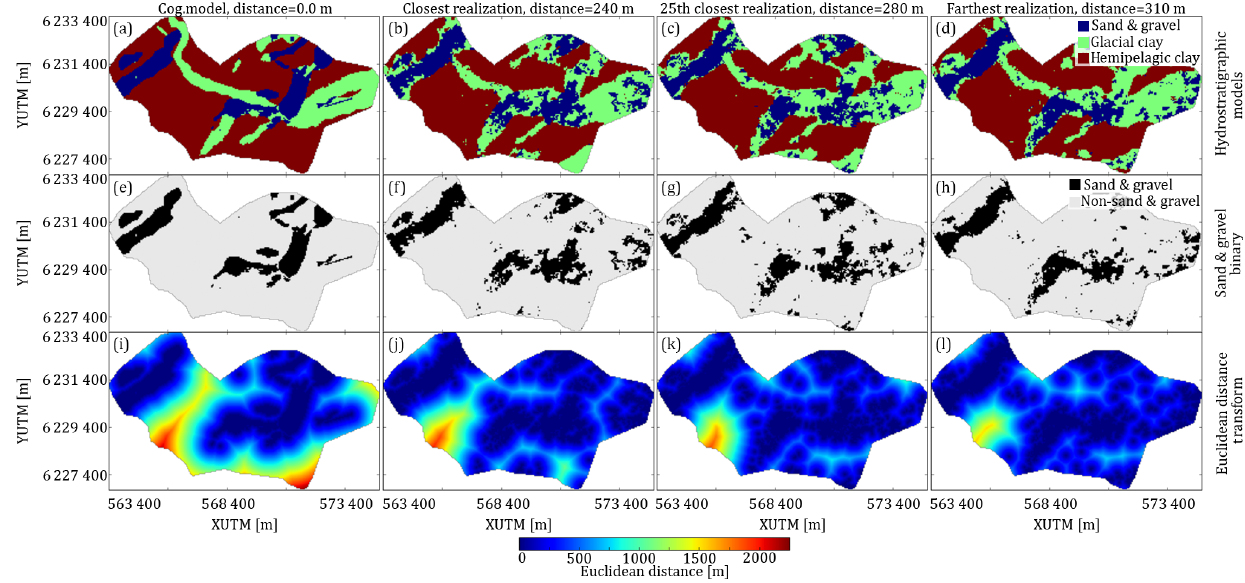
Figure 2. A 2-D example of the Euclidean distance transforms (EDT) as a measure for the similarity between categorical MPS realizations. In this example a set of 50 realizations, from the basic modeling setup, are compared based on the differences in EDT for sand and gravel units. (a–d) show the hydrostratigraphic models for the TI, closest realization, 25th closest realizations, and farthest realization, respectively. (e–h) show, in the same order as above, the binary images of the sand and gravel units of the 2-D hydrostratigraphic model layers. (i–l) show, in the same order as above, the Euclidean distances layers computed from the 2-D sand and gravel binary